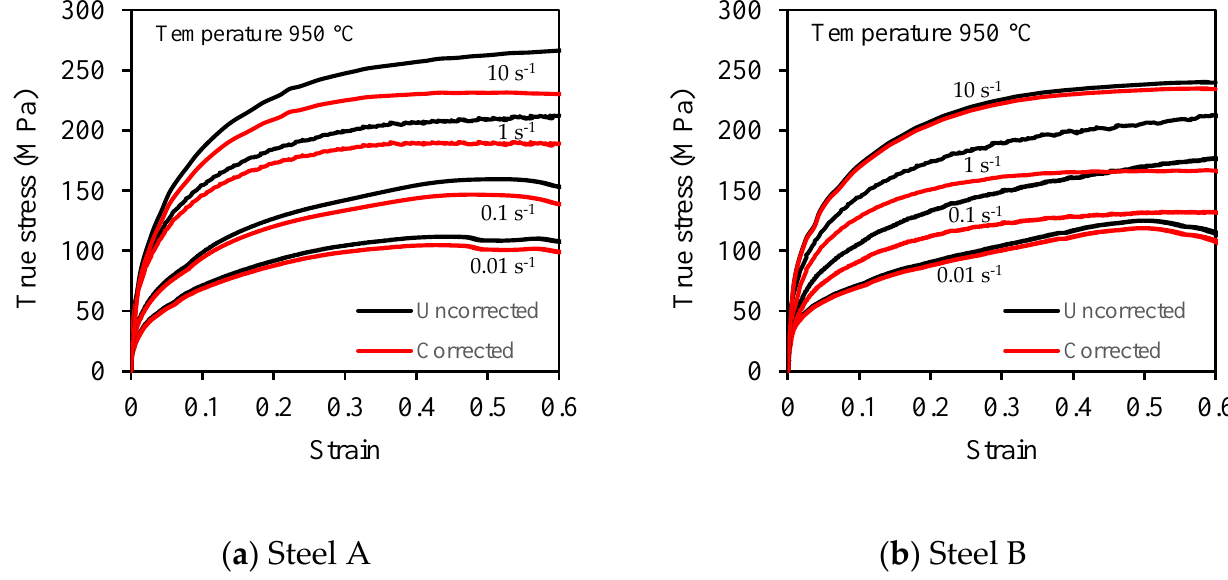
Figure 4. Plots of uncorrected and corrected flow stress–strain curves.